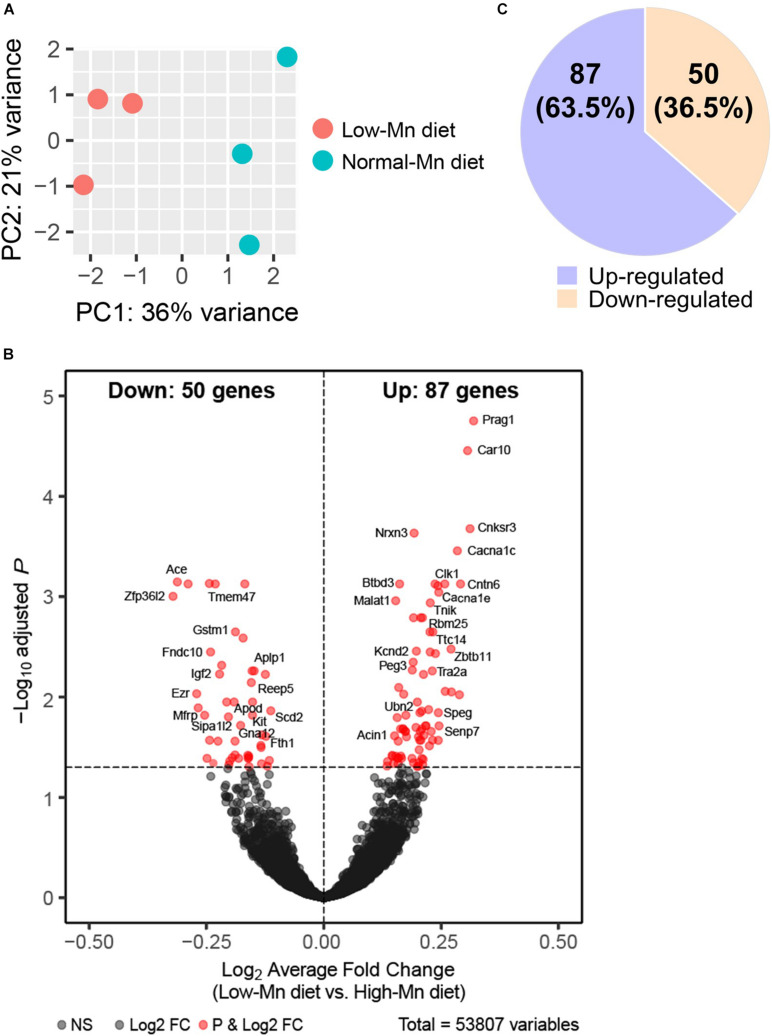
RNA-Seq analysis of manganese (Mn)-deficient cerebellum in mice. (A) Principal component analysis (PCA) plot showing the clustering of each of the samples with technical triplicates along two principle components (PC1 – 36% variance; PC2 – 21% variance). Each technical triplicate clusters with the other. (B) DESeq reveals 137 altered genes (significantly altered genes defined as a Padj-value < 0.05). Volcano plot profiles –log10 Padj-value and log2-fold change of gene expression between Mn-deficient vs. normal cerebellum samples. (C) 50 genes (36.5%) are downregulated and 87 genes (63.5%) are upregulated.